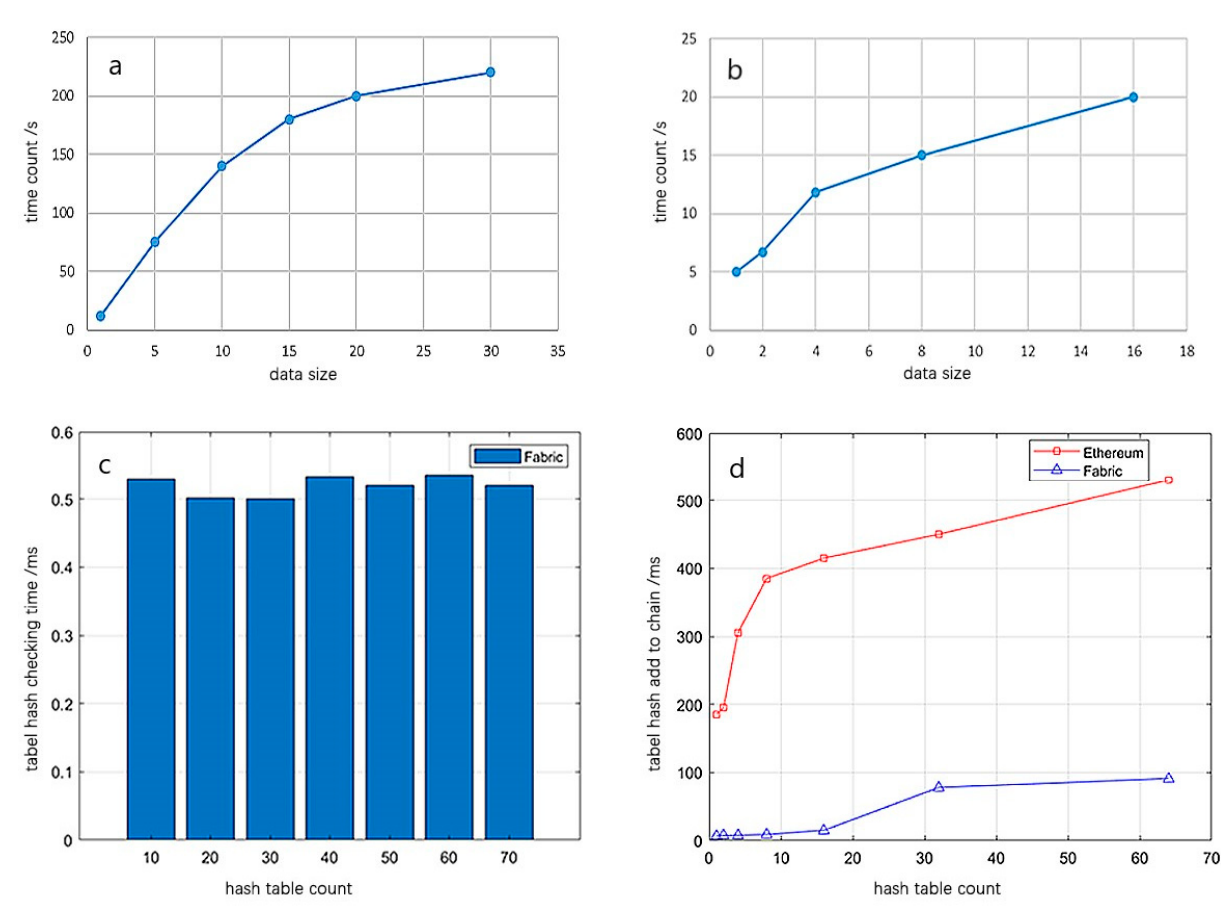
Figure 9. Time consumption of each link of the system and efficiency comparison of different types of chains. ( a ) Data encryption; ( b ) Add hash to chain; ( c ) Data checking; ( d ) The efficiency of contrast.